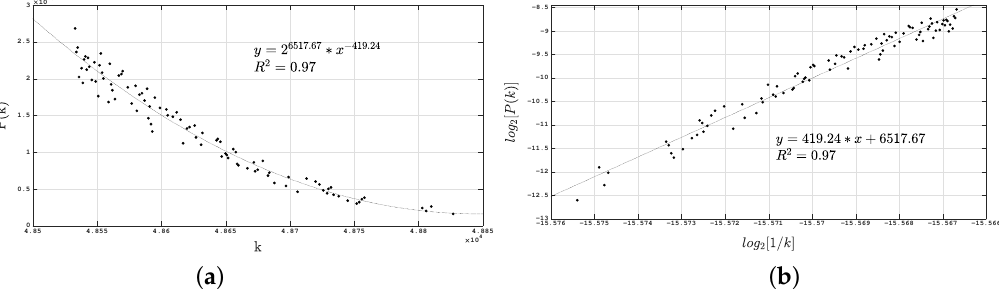
Figure 7. ( a ) P ( k ) vs. k plot and ( b ) log 2 [ P ( k )] vs. log 2 ( 1/ k ) plot generated from the 3D Visibility Graph for the data space [ z , x , y ] ss . R 2 is a statistical measure of fit that indicates how much variation of a dependent variable is explained by the independent variable(s) in a regression model.